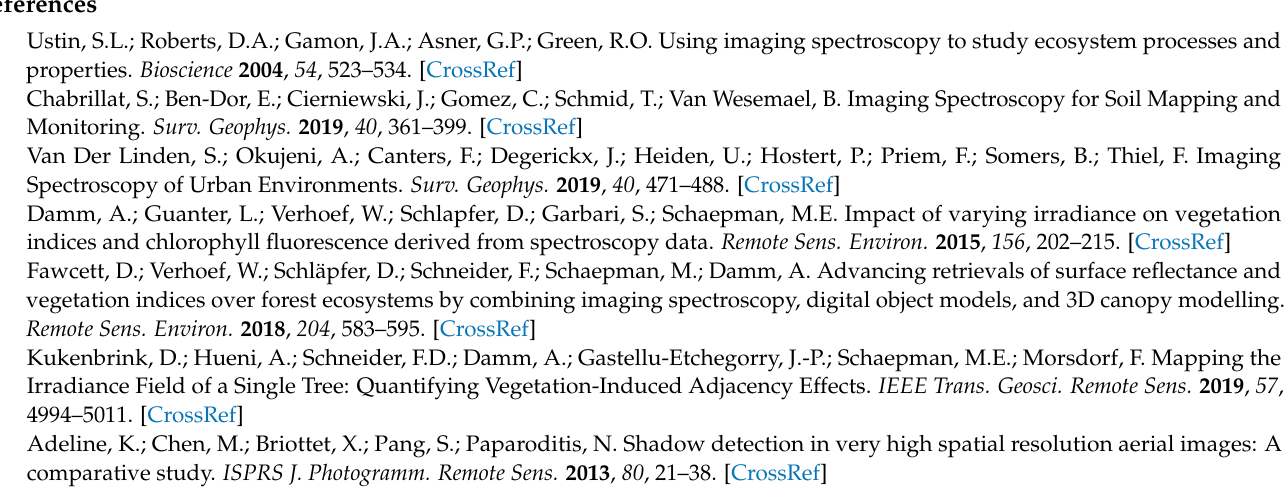
Figure A2. Illustrations of the five steps of radiation propagation (top: adapted from DART user manual) and the extraction of the radiative components